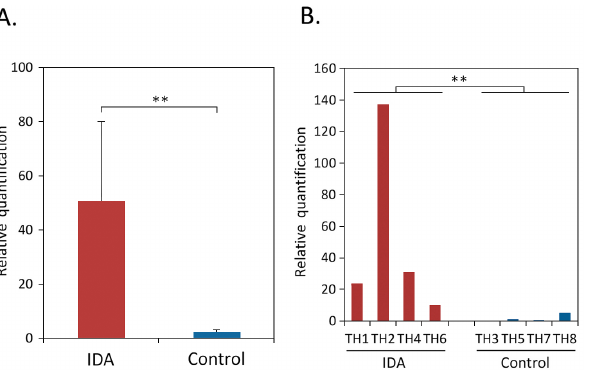
Fig 3. Transcription of sabA gene in IDA or control strains by real-time RT-qPCR. Panel A: overall expression(relative quantitation) of sabA in the four IDA and four control strains, respectively. Panel B: expression(relative quantitation) of sabA in the eight strains studiedeach. Expression of sabA was normalized in relationto house-keeping gene gyrA . For relativequantitation, H . pylori TH5 (control) strain was used as control, because expression value of the strain was the least (definedas 1.0). Panel A: results are shown as the Mean ± SE for triplicate determinations. ** p = 0.029, using Wilcoxon rank sum test.